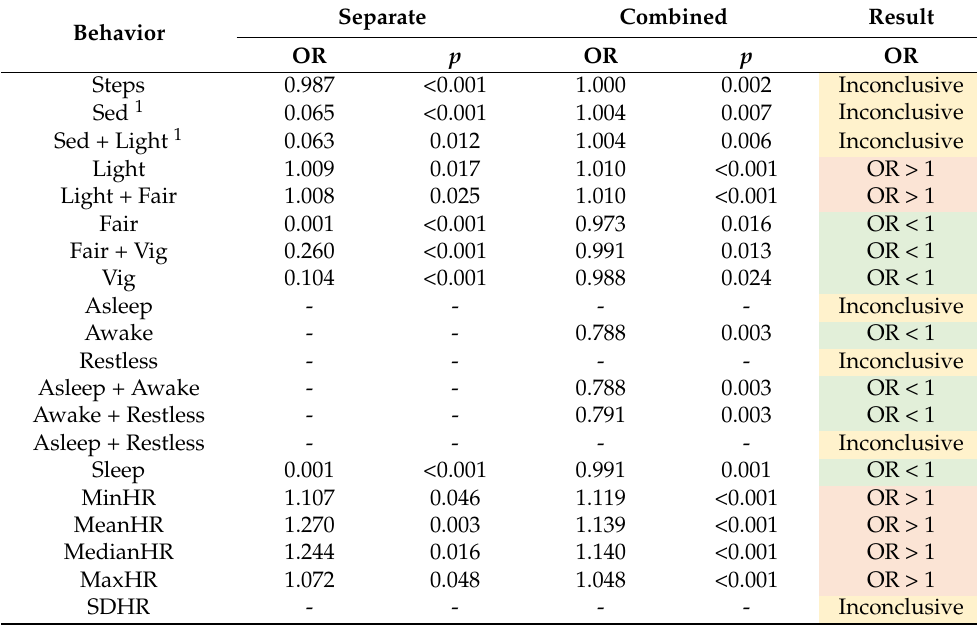
Table A11. Results across all conditional logistic regression models in validation scenario type 3.